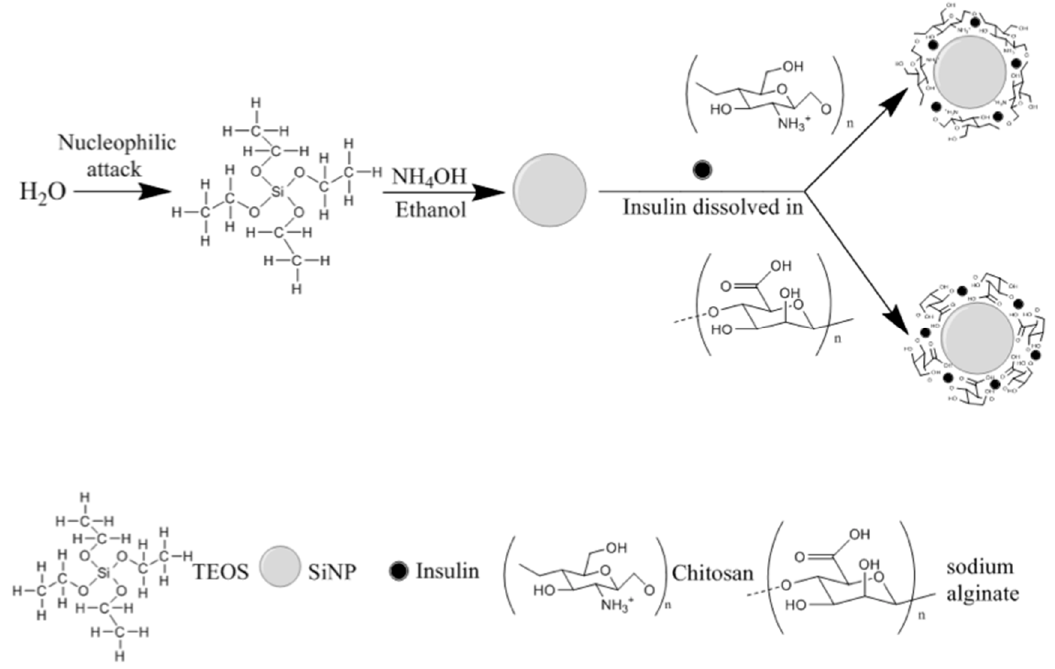
Figure 2. A schematic diagram for the synthesis of hybrid nanoparticles.